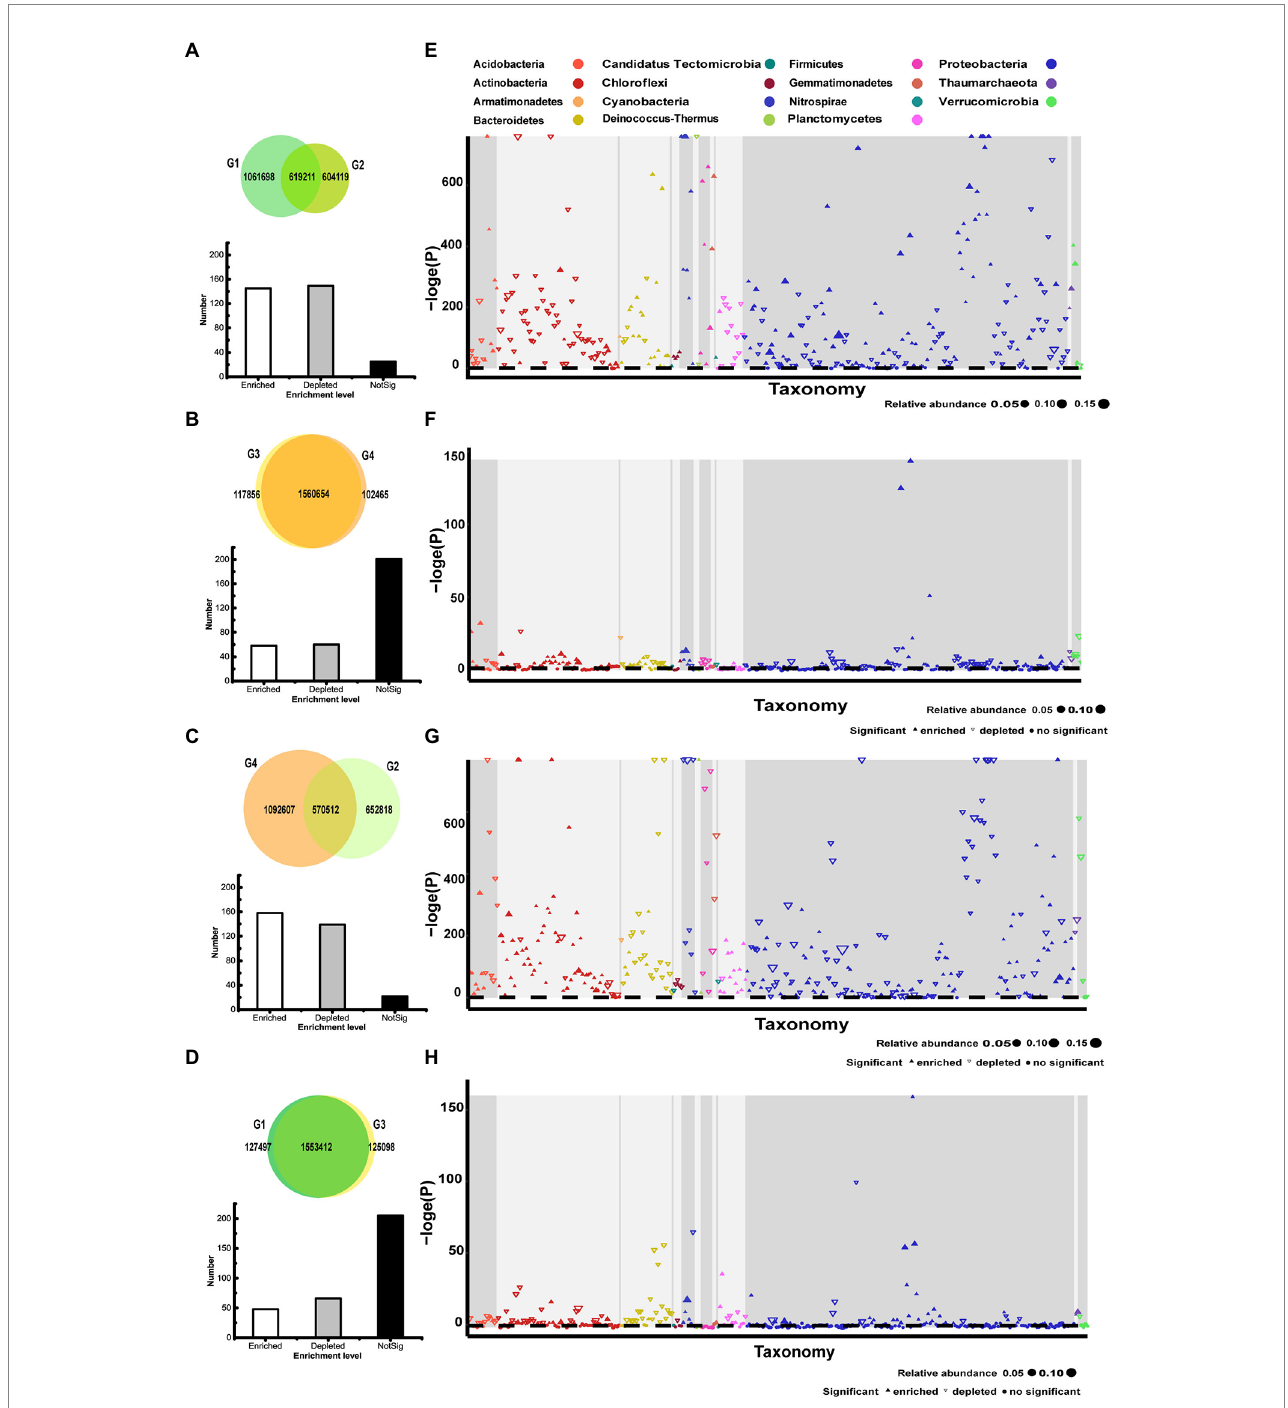
FIGURE 2 Taxonomic characteristics of differential OTUs between different groups. (A) Overlapping OTUs enriched in G1 and G2. (B) Overlapping OTUs enriched in G3 and G4. (C) Overlapping OTUs enriched in G2 and G4. (D) Overlapping OTUs enriched in G1 and G3. (E) Manhattan plot of OTUs enriched in G1 or G2. (F) Manhattan plot of OTUs enriched in G3 or G4. (G) Manhattan plot of OTUs enriched in G2 or G4. (H) Manhattan plot of OTUs enriched in G1 or G3. G1, 101-14 treated with NaCl; G2, 101-14 treated with ddH 2 O; G3, 5BB treated with NaCl; G4, 5BB treated with ddH 2